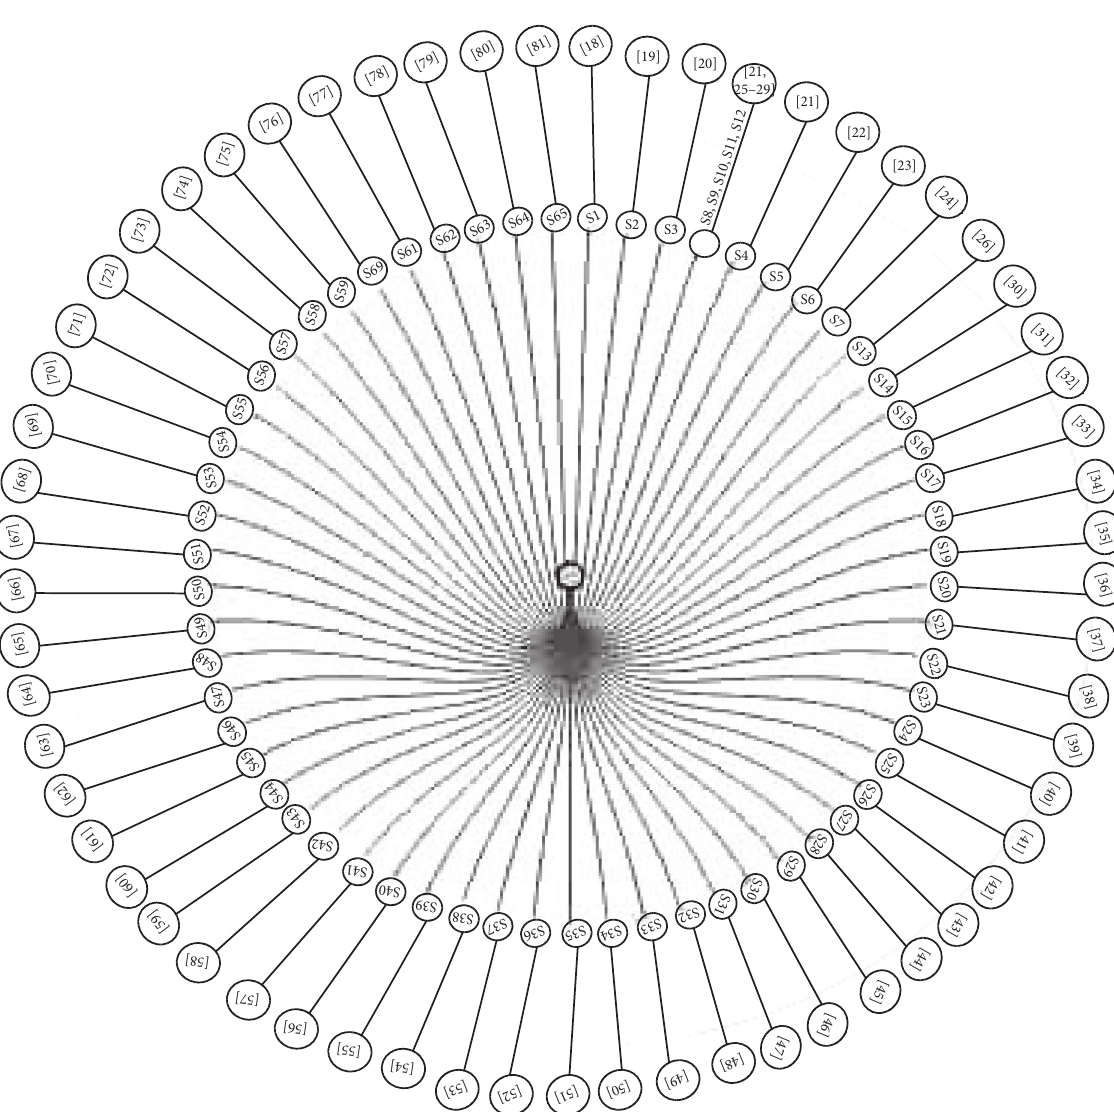
Figure 14: List of the selected